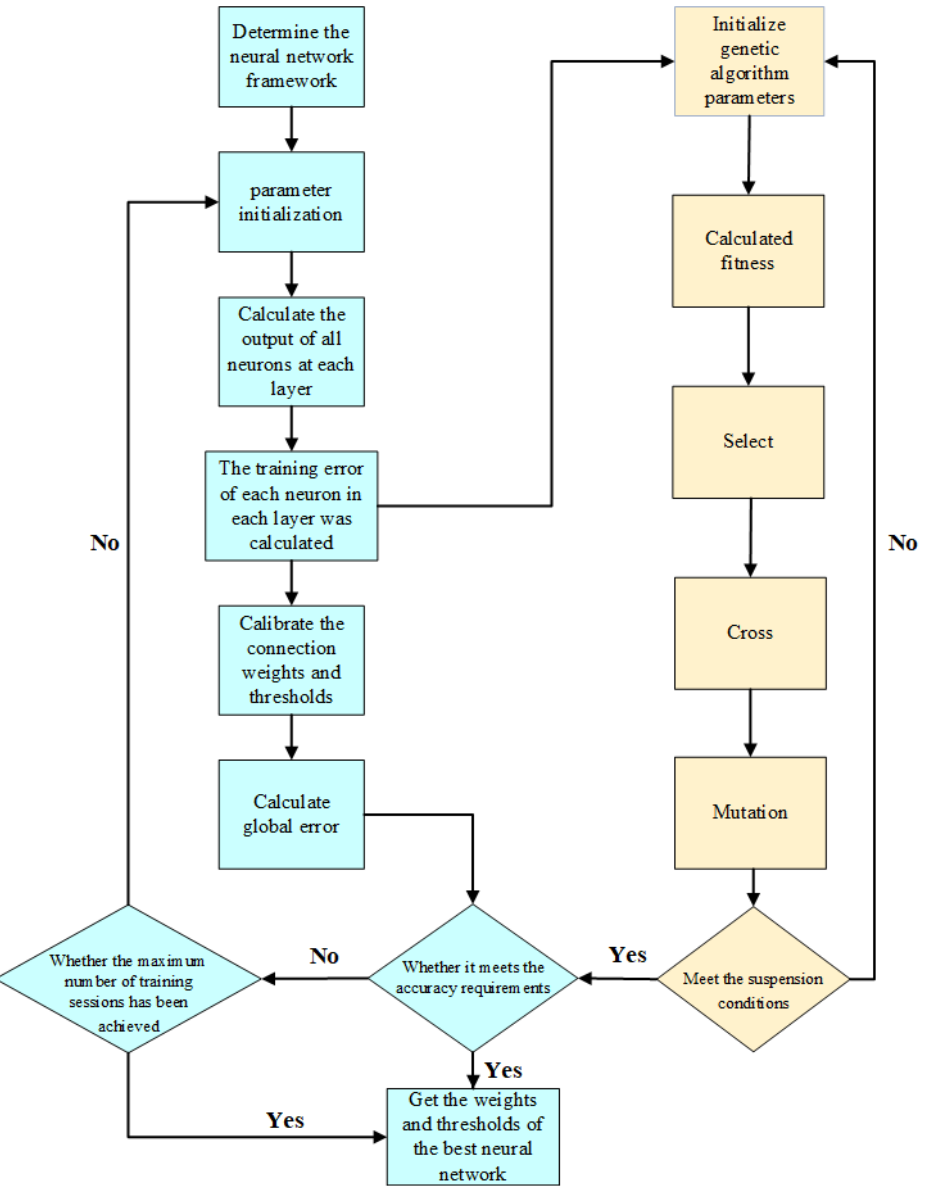
Figure 5. Schematic diagram of the calculation process, in which the blue part represents the standard BPNN, while the yellow part illustrates the optimization process based on the standard BPNN using the genetic algorithm.